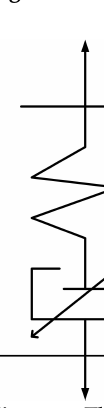
Figure 3. The Conformable Maxwell model.